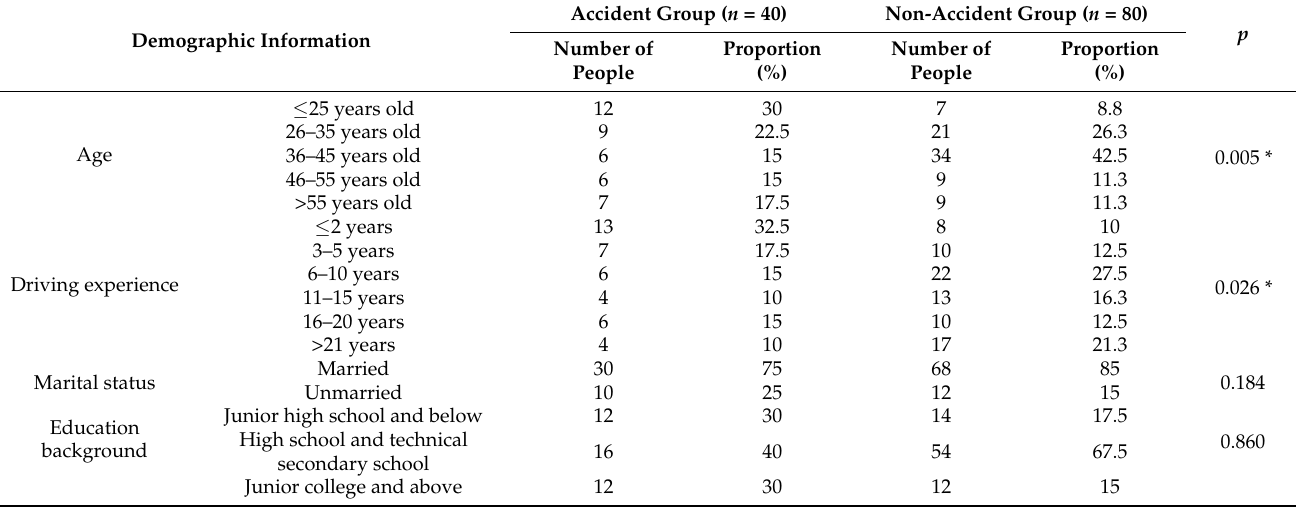
Table 1. Comparison of demographic information between the accident group and non-accident group of bus